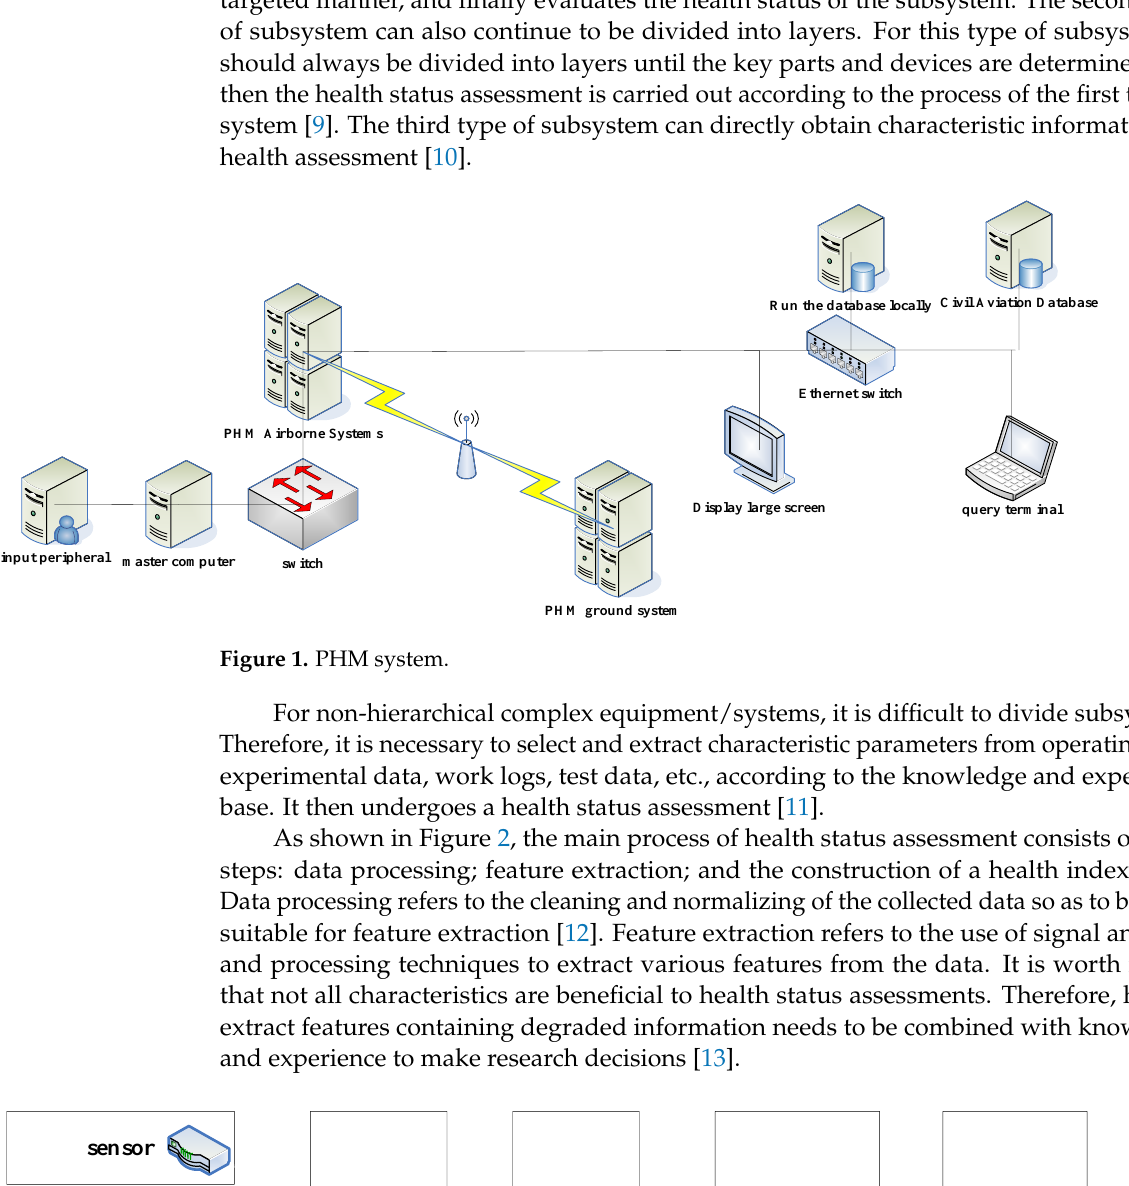
Figure 1. PHM system .